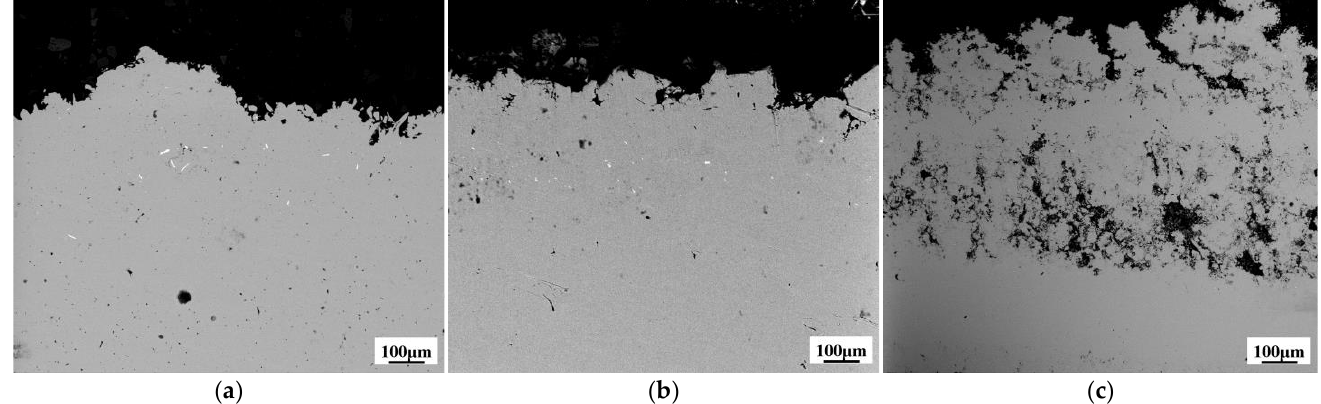
Figure 5. The cross-sectional SEM images of W – Cu composite coatings under different forward duty cycles: ( a ) d f = 20%, ( b ) d f = 40%, and ( c ) d f = 60%, ( J = 2 A/dm 2 , f = 1500 Hz and d r = 5%).